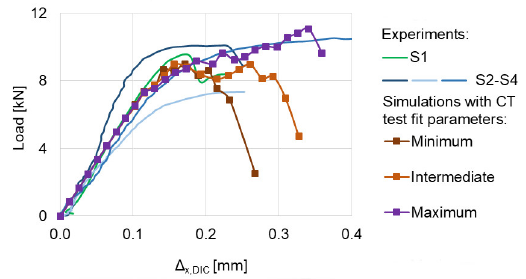
Figure 11. Load vs. DIC relative vertical displace- ment ∆ x,DIC for the results of ASTM shear test exper- iments and simulations calculated with the minimum, intermediate, and maximum parameters from Table 2 and δ m,crit = 0 . 055 mm.